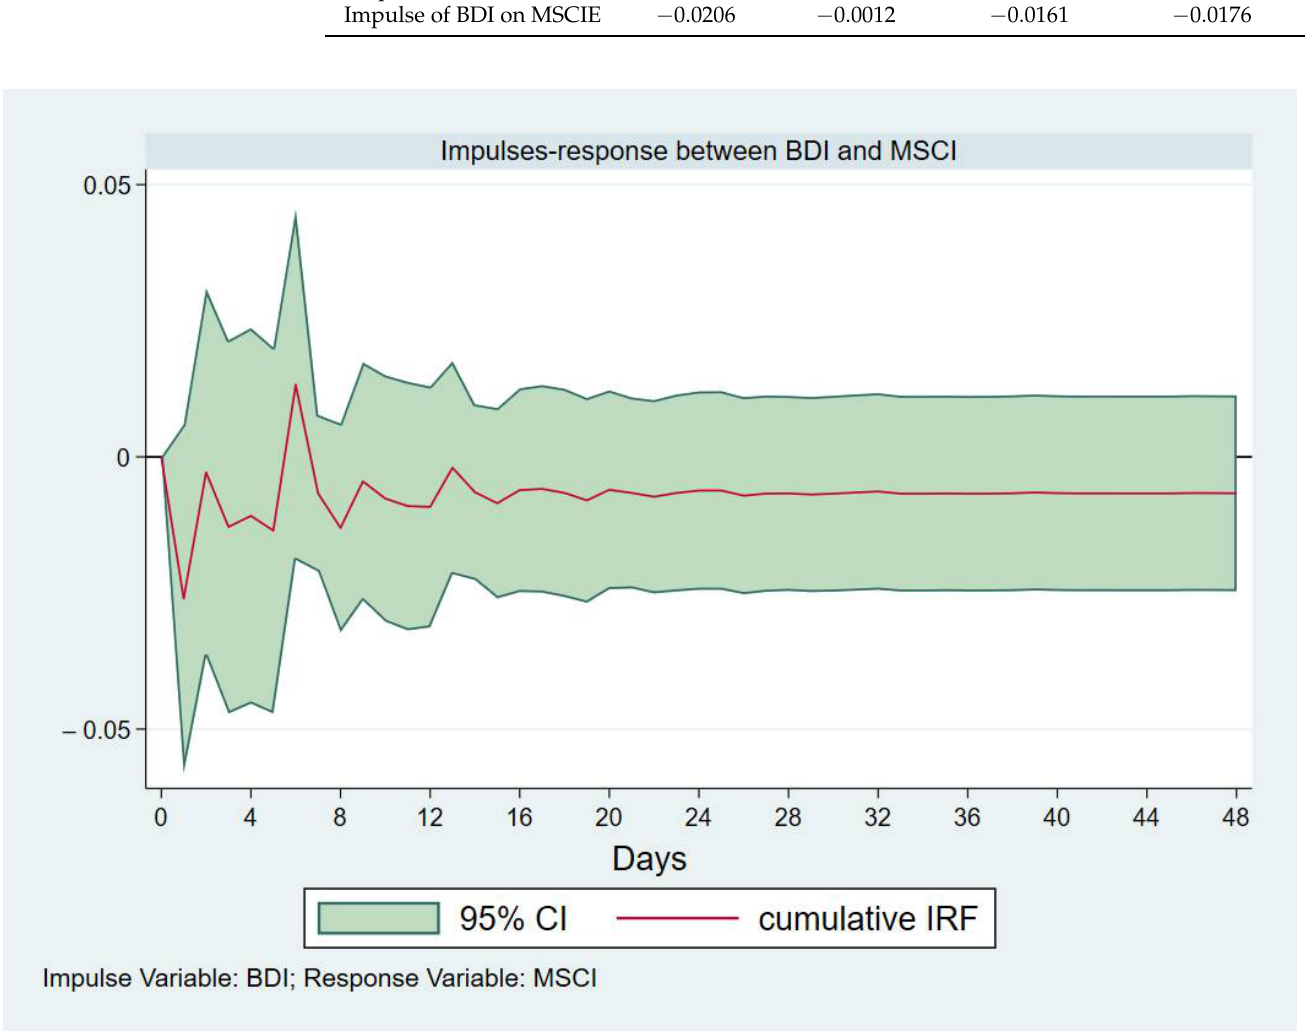
Figure 8. Cumulative impulse response of MSCI to BDI. Note: The red line represents the estimates, while the green bands represent lower and upper bounds to the 95% confidence intervals.